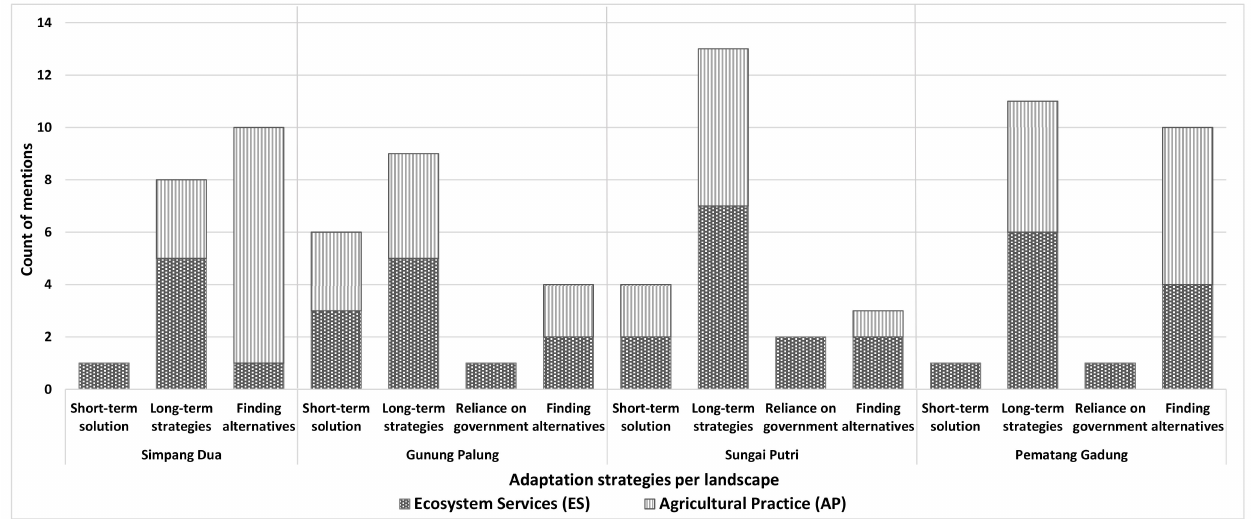
Figure 5. Adaptation strategies in four landscapes for the two impact groups.